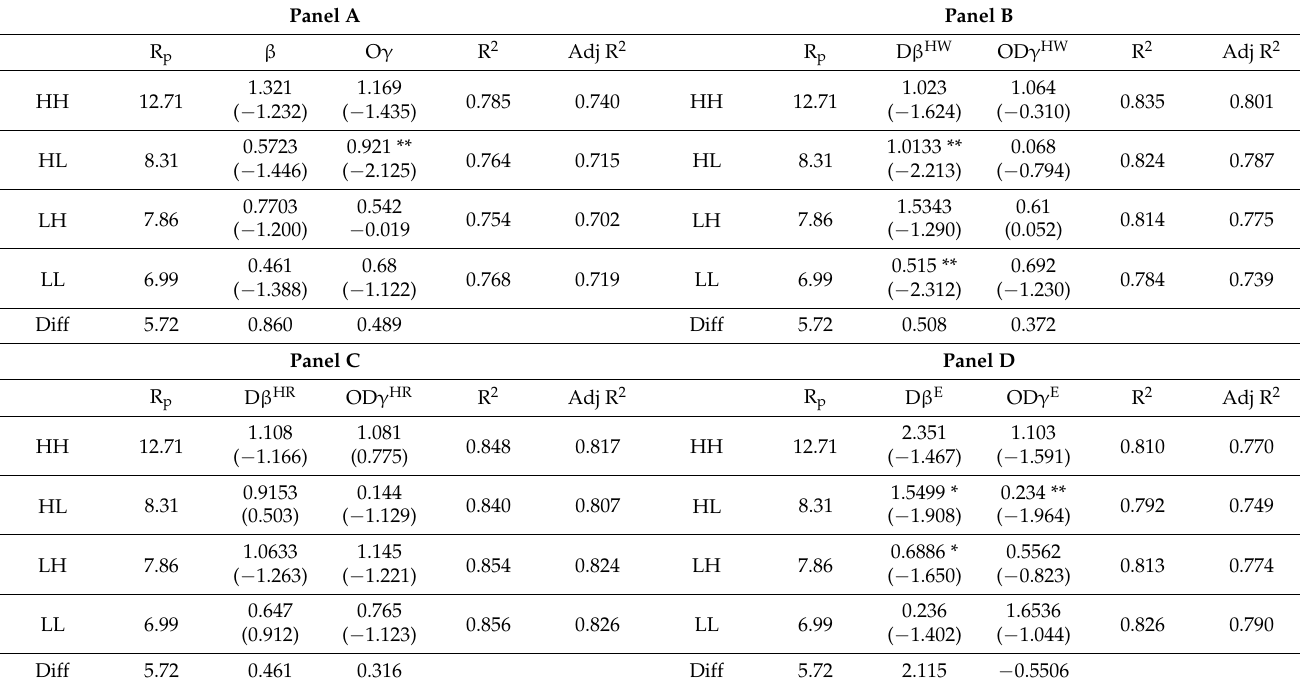
Table 3. Results for β , D β HW , D β HR , and D β E with O γ , OD γ HW , OD γ HR , and OD γ E , respectively, with R 2 and Adj R 2 and their t -stat in ( ). Diff is the difference of returns between HH and LL showing the risk–return relationship. Panel A Panel B